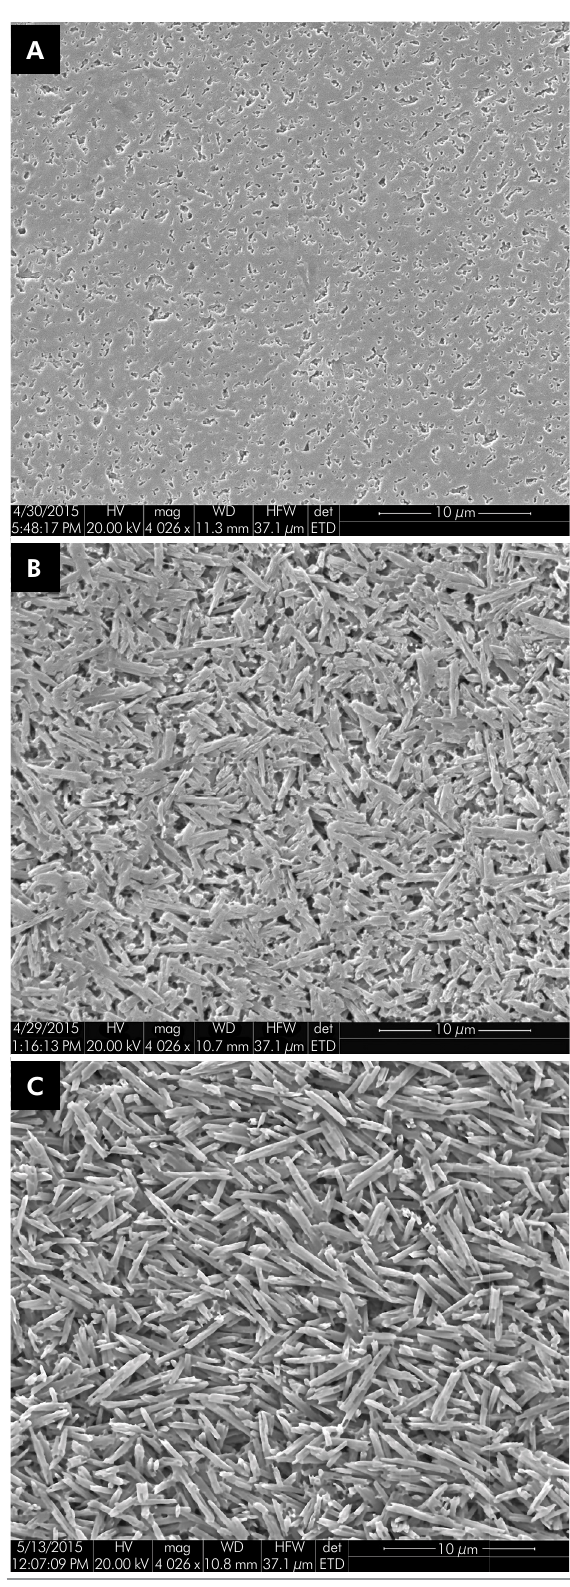
Figure 1. Resulted etching pattern on IPS e.max Press with 1% (A), 5% (B) and 10% (C) hydrofluoric acid applied for 20